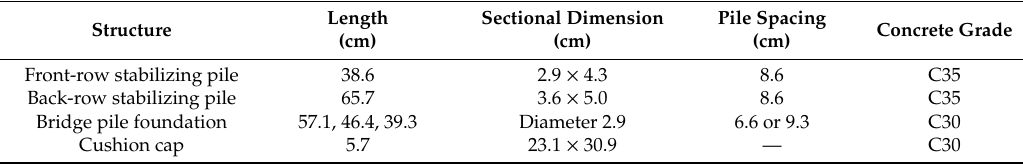
Table 7. Structural dimensions of bridge foundation and anti-slide